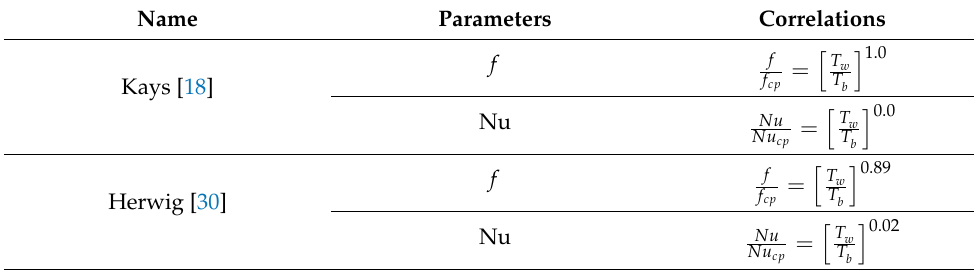
Table 3. Existing variable property correlations of laminar flow and heat transfer.